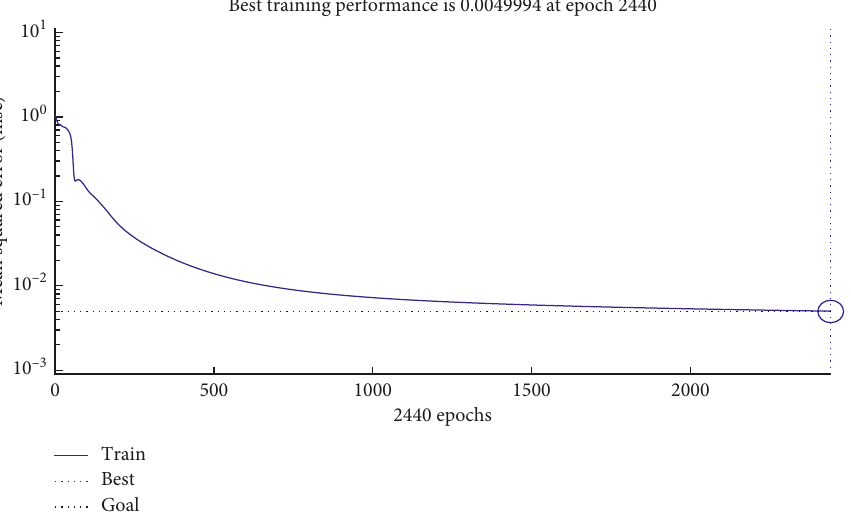
Figure 12: The neural training regression. The training goal mse (training error) is set as 0.005, and the maximum goal epoch is set as 5000. We obtain that the best training performance (training error) is 0.0049994 at epoch